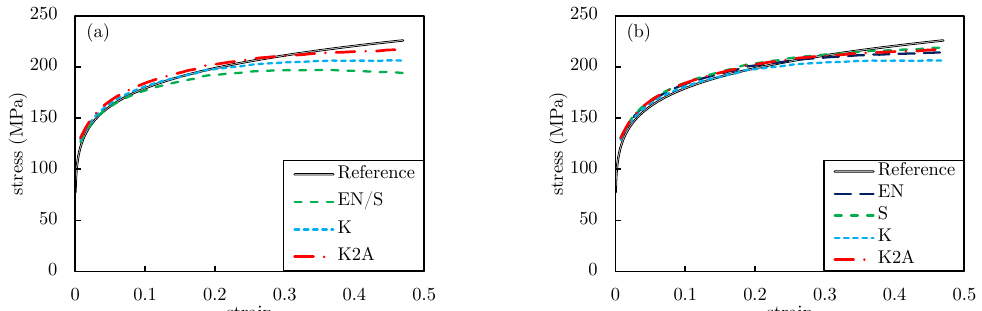
Figure A1. The assigned stress-strain curve for sample #6 and those obtained from A-CPM using the estimates of b A that are developed with a static method for the ( a ) forward and ( b ) backward Euler kinematics. (The formulation of b EN and b S is the same for the forward Euler kinematics in the static method).